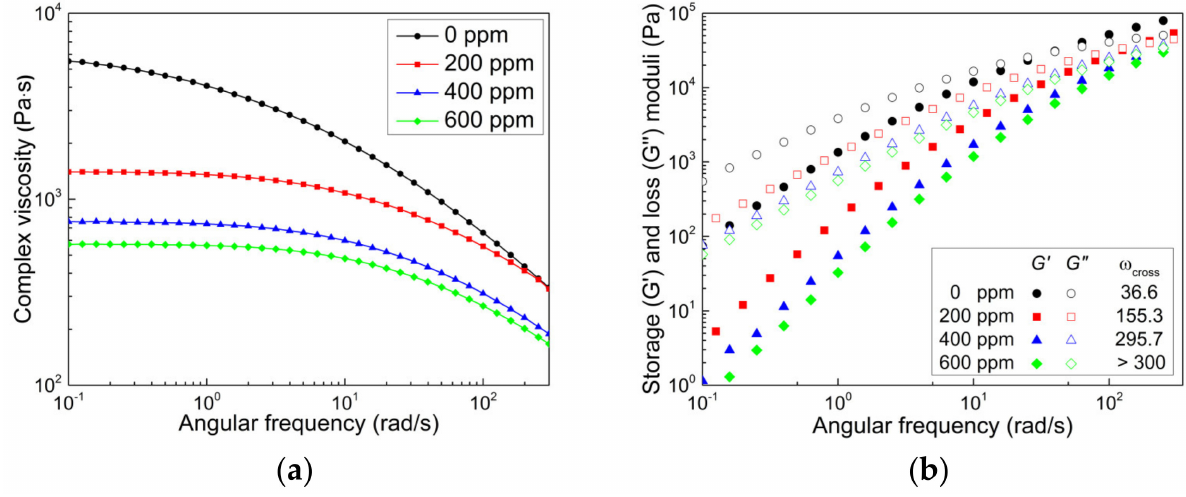
Figure 5. Rheological properties of neat PP and CR-PPs. ( a ) Complex viscosity and ( b ) storage (G’) and loss (G”)